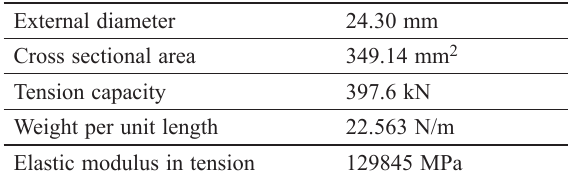
Table 4. Properties of the OPGW shield wire External diameter